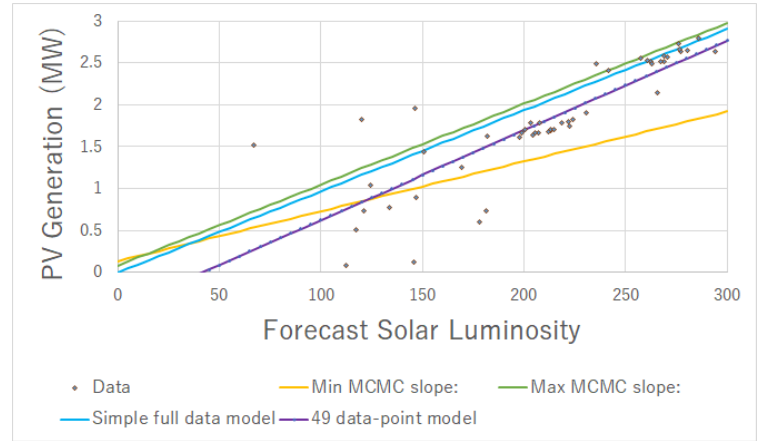
Figure 3. Various fits to the data including the prior simple model fitted to the full data, a best fit to the 49 data points of close periods and the minimum and maximum slope results from the MCMC